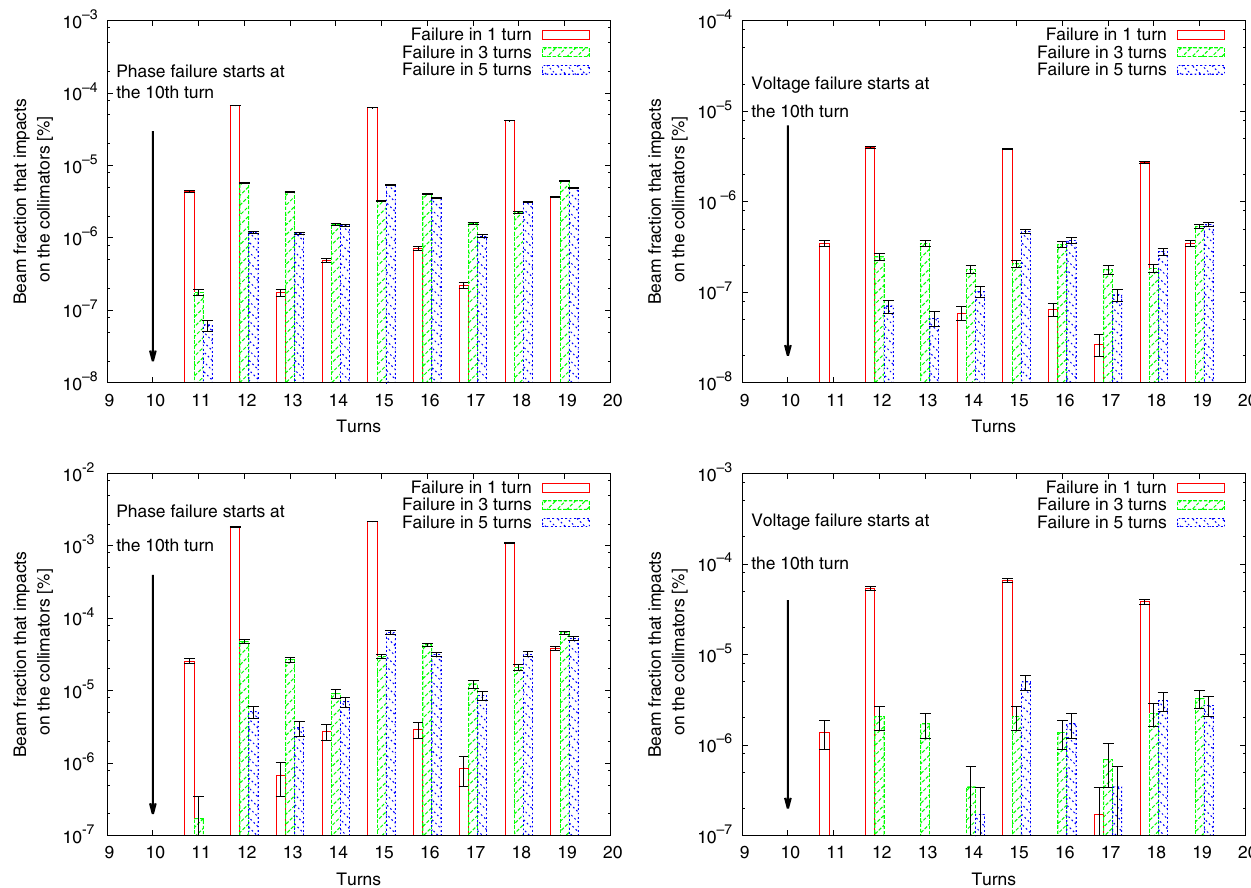
FIG. 8. Percentage of beam that impacts on the collimators turn by turn, after the failure started, for the PF (left) and VF (right) cases considering the SG II (top) and SG III (bottom) distributions.